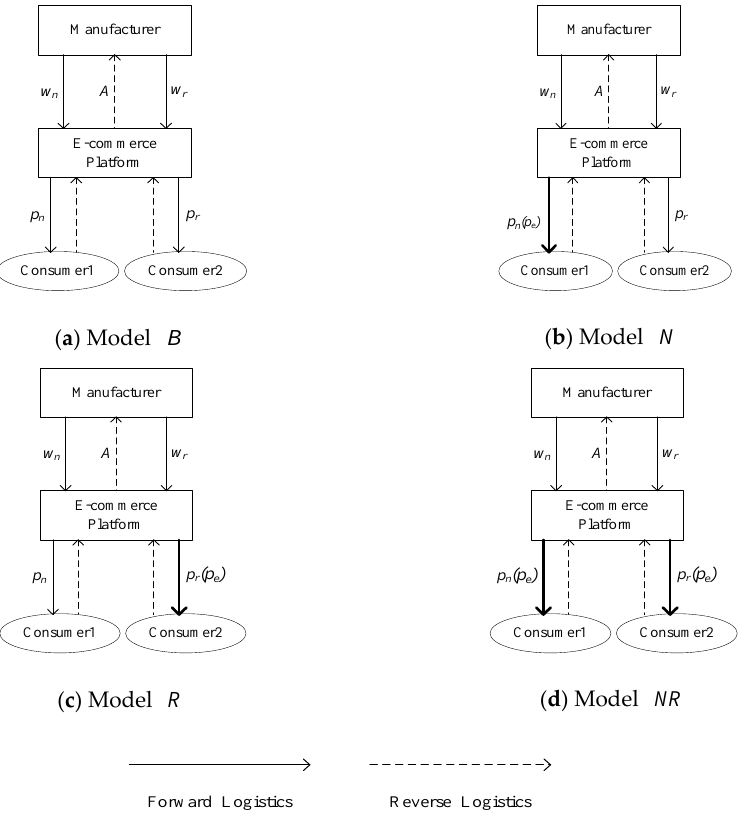
Figure 1. Structure of the four models in a CLSC.